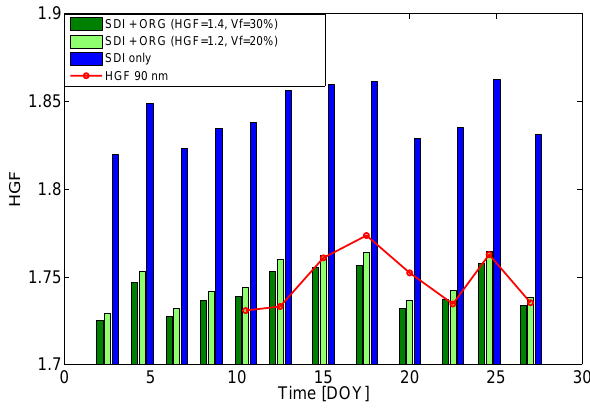
Fig. 14. Hygroscopic growth factor estimates based on HGF liter- ature values of H 2 SO 4 , (NH 4 )HSO 4 , (NH 4 ) 2 SO 4 , Sea Salt (SS), MSA and organic species (ORG). The volume fractions (except ORG) were derived from the masses of SDI-impactor three lowest stages presented in Fig. 12. Estimations were done with (in green) and without (in blue) the additional organics. For additional organ- ics two scenarios were tested. In the first scenario, 30% of organics (30% addition to the total mass of inorganic species) with HGF of 1.4 were added (dark green) while in the second scenario 20% of or- ganics with HGF of 1.2 were added. HGF and density values used in the chemical species HGF estimation are presented in Table